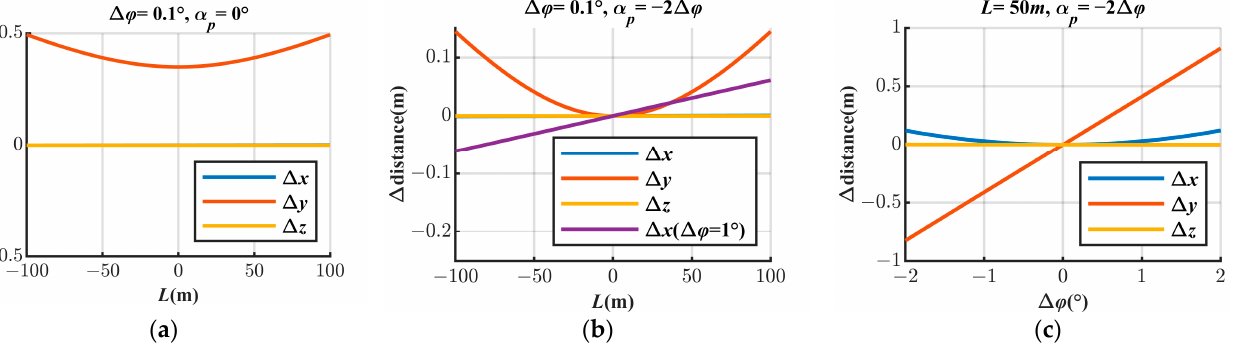
Figure 17. The effect of ∆ ϕ on the point coordinates. ( a ) Without α p compensation, ∆ x , ∆ y , ∆ z change with L ; ( b ) After using pitch angle α p compensation, when ∆ ϕ = 0.1 ◦ , ∆ x , ∆ y , ∆ z change with L . In order to show the change trend of ∆ x , a change curve of ∆ x when ∆ ϕ = 1 ◦ is added; ( c ) After using pitch angle α p compensation, when L = 50 m, ∆ x , ∆ y , ∆ z change with ∆ ϕ